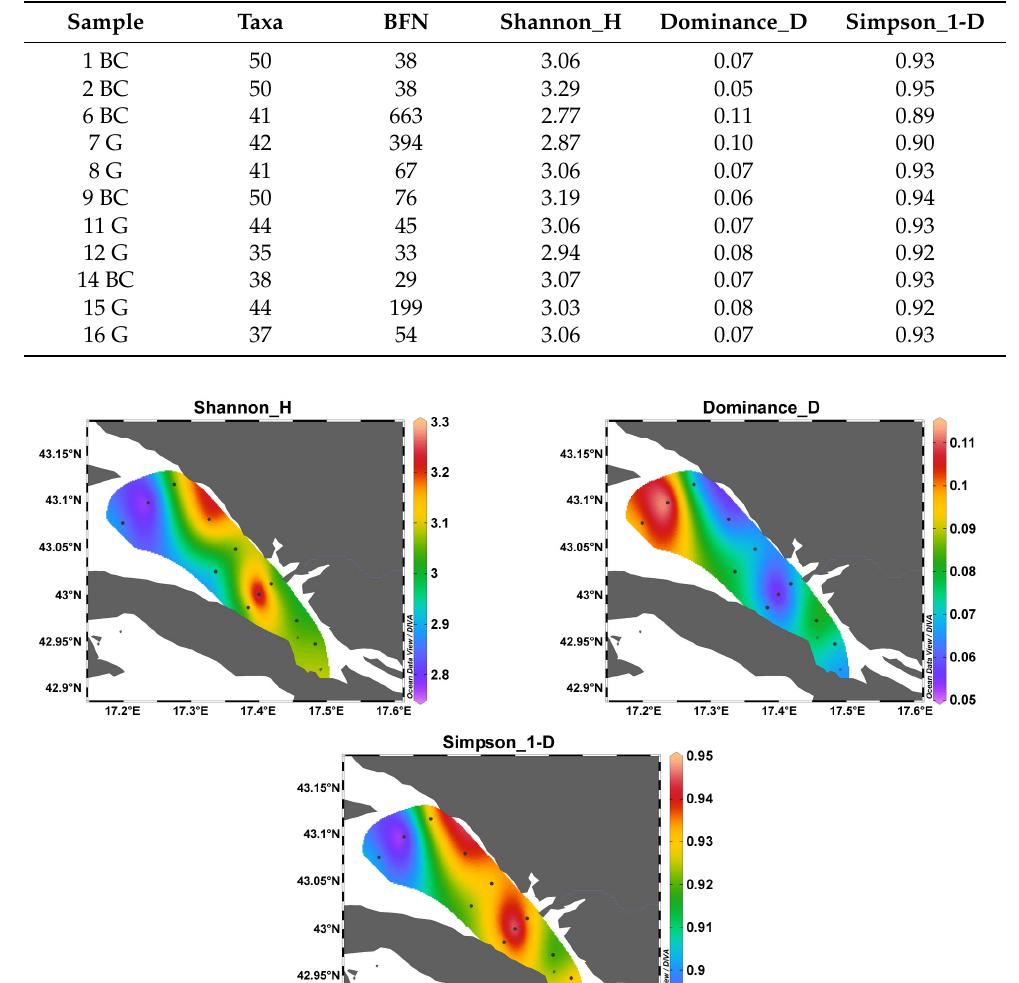
Table 3. Diversity indexes for the foraminifera assemblages in the different samples: number of Taxa, number of specimens/gr sediment (BFN), Shannon–Wiener entropy index (H), Dominance (D) and Simpson’s Index of Diversity (1-D).